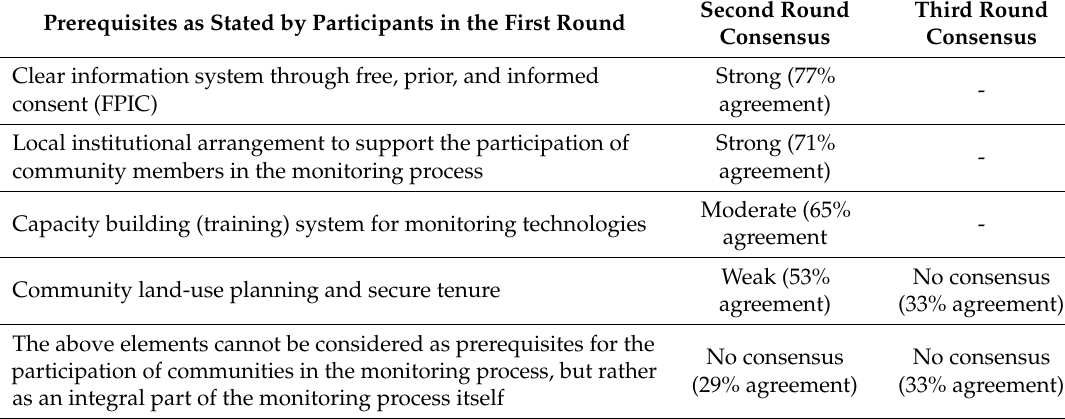
Table 3. Prerequisites in Delphi panel results for the full and e ff ective participation of communities in the monitoring process of REDD + projects in the